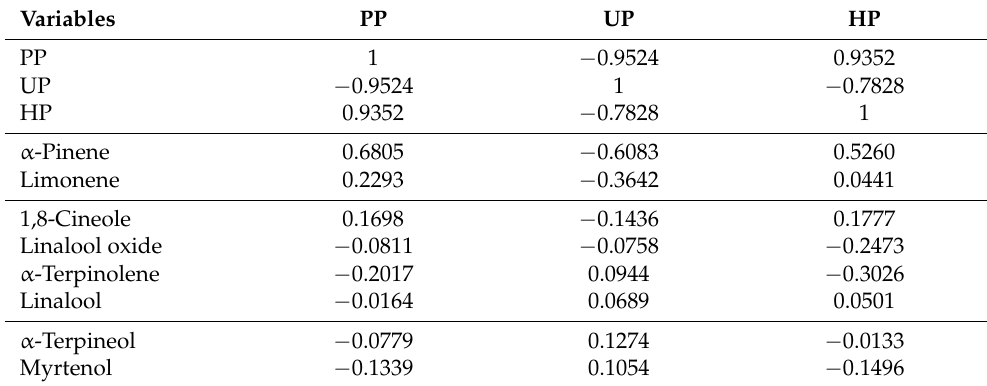
Figure 4. Principal component analysis (PCA) of the oral pre-treatment with microencapsulated M. communis essential oil (MMEO) showing the correlation between essential oil components and anti-inflammatory parameters. The first two components (PCs) contributed 98.41% to cumulative variance, with PC1 (F1 axis) and PC2 (F2 axis) explaining 72.85 and 25.56% of the total variance. Table 3. Pearson’s correlation coefficients of ulcer-protective parameters with EO